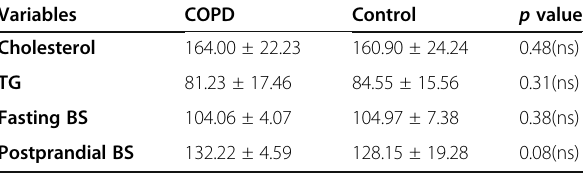
Table 3 Lipid profile and blood sugar among studied groups Variables